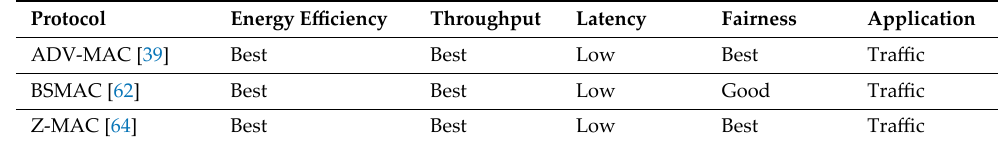
Table 5. Comparison of hybrid